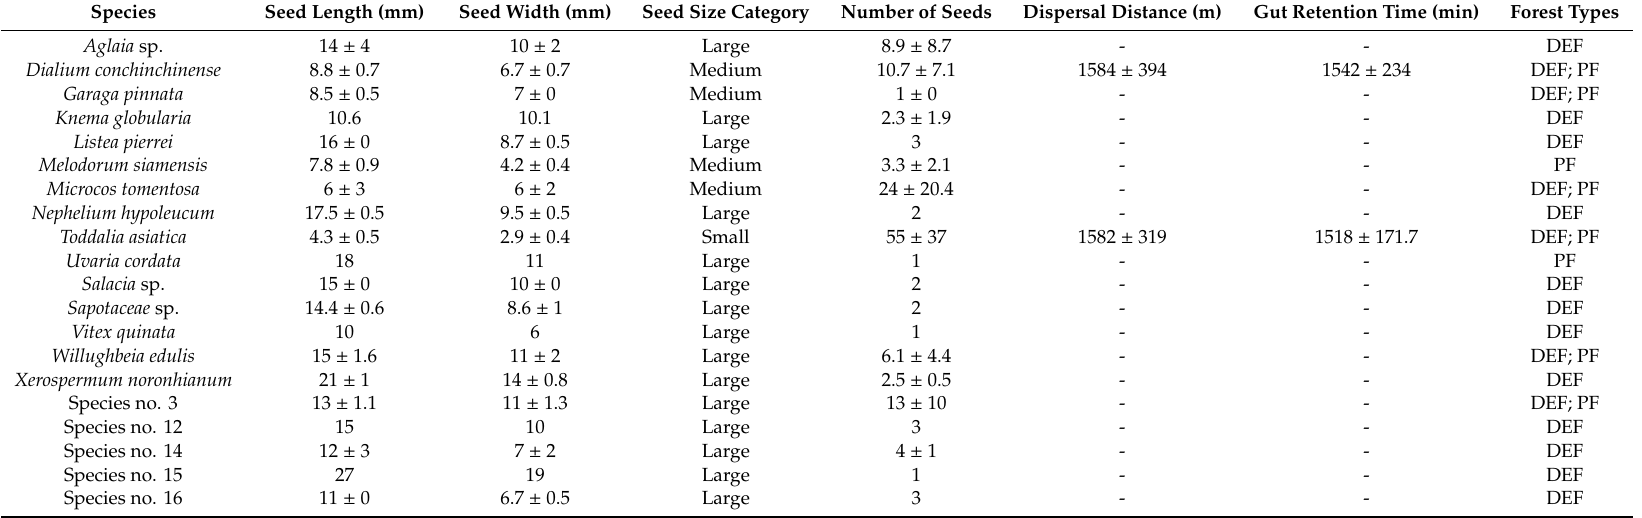
Table 3. Intact seed species within macaques’ feces in Sakaerat: mean size ± SD, mean number ± SD, observed mean dispersal distance ± SD, mean gut retention time ± SD and forest types in which they were